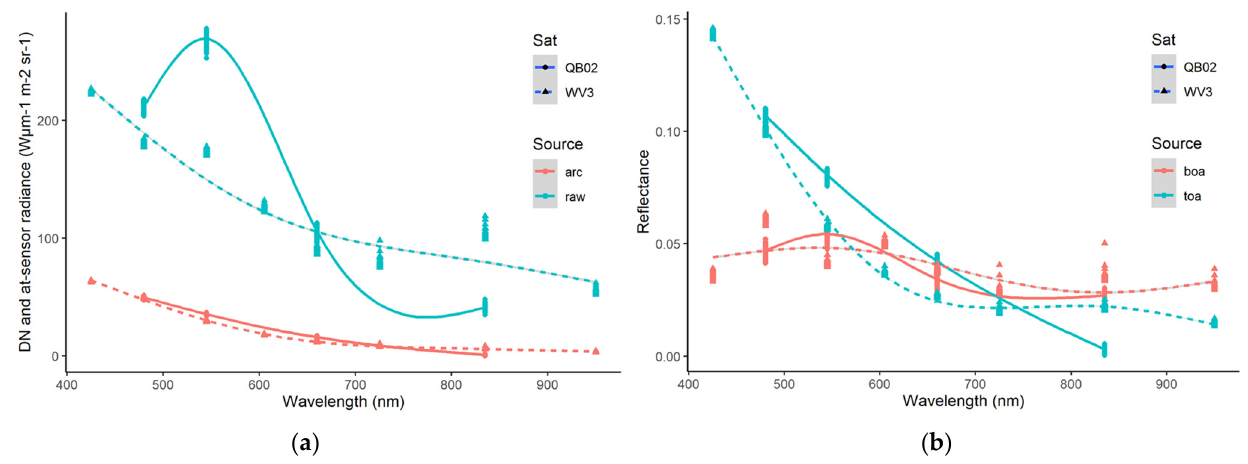
Figure 4. Reflectance spectra of deep-water pixels from both images for all 4 product types. The full line and circles refer to image 1 (QB02), and the dotted lines and triangles refer to image 2 (WV3). ( a ) Shows the raw image in digital numbers (DN) and the absolute radiometric calibrated (arc) at-sensor radiance product. ( b ) Shows the top and bottom of atmosphere reflectance spectra (toa and boa, respectively).